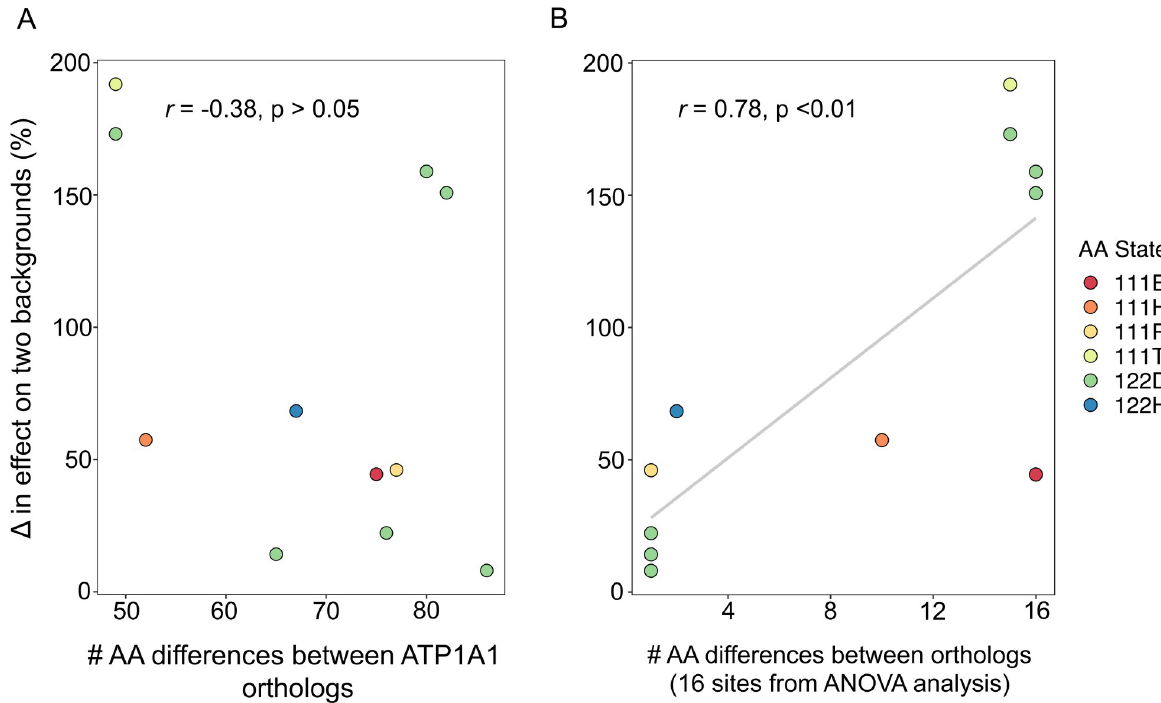
Fig 5. A small number of sites account for a large proportion of the differences in pleiotropic effects of the same substitution on divergent ATP1A1 backgrounds. (A) The difference in effect size of a mutation to a given state on two different backgrounds as a function of divergence at all sites. Each point represents a comparison between the effect (% change in activity relative to the wild-type enzyme) of a given amino acid state (e.g.,122D) on two different genetic backgrounds. For example, the effect of 122D between chinchilla and false fer-de-lance is measured as | Δ % [chinchilla vs. chinchilla+N122D] minus the Δ % [false fer-de-lance vs. false fer-de-lance+H122D]|. Comparisons were measured as the difference between the two effects. The x-axis represents the number of amino acid differences between two wild-type ATP1A1 proteins (i.e., backgrounds) being compared. Assuming intramolecular epistasis for protein function is prevalent, a positive correlation is predicted. In total, 11 comparisons were possible, and no significant correlation is observed when considering divergence at all sites. (B) The difference in effect size of a mutation to a given state on two different backgrounds as a function of divergence at a subset of 16 sites with the largest effects on the difference in activity between two backgrounds. The p-value of the correlation was determined by permuting effects among constructs and generating a null distribution of